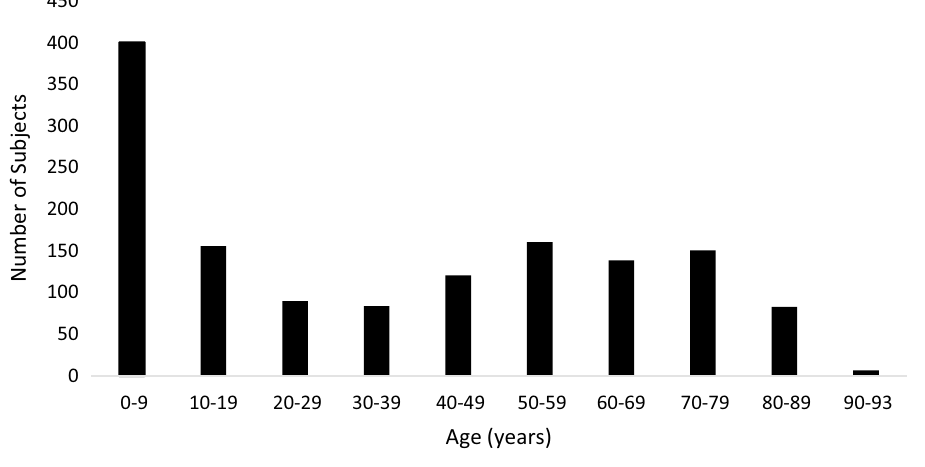
Figure 2. Subjects with functional low vision per age